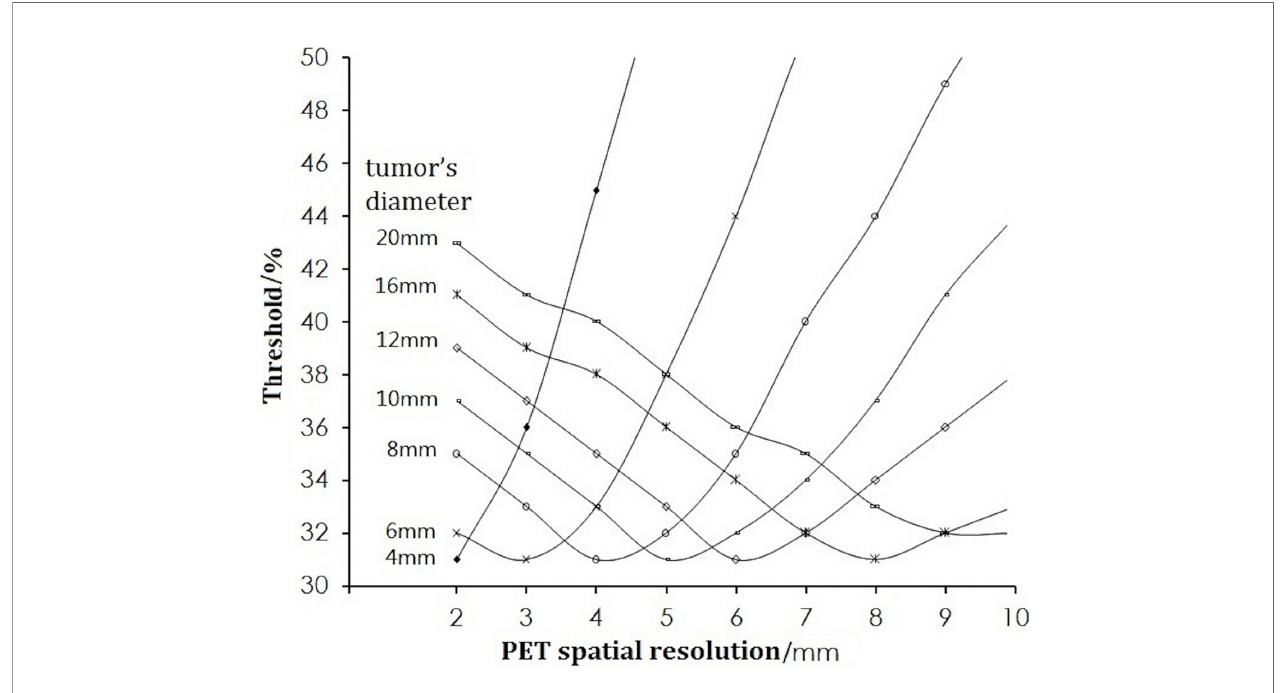
FIGURE 3 | Change in the threshold with the spatial